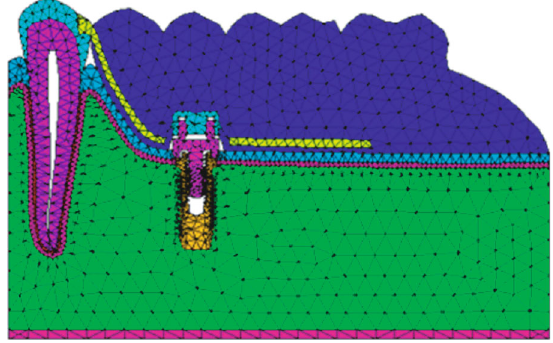
Figure 5: First biomodels of dental